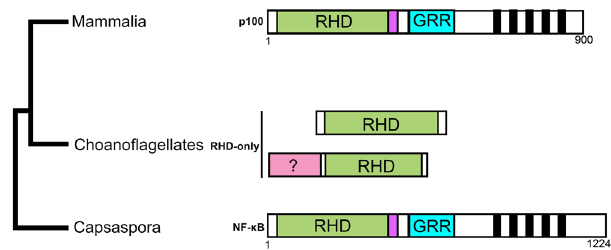
Blue, GRR (glycine-rich region); Black bars, Ankyrin repeats;